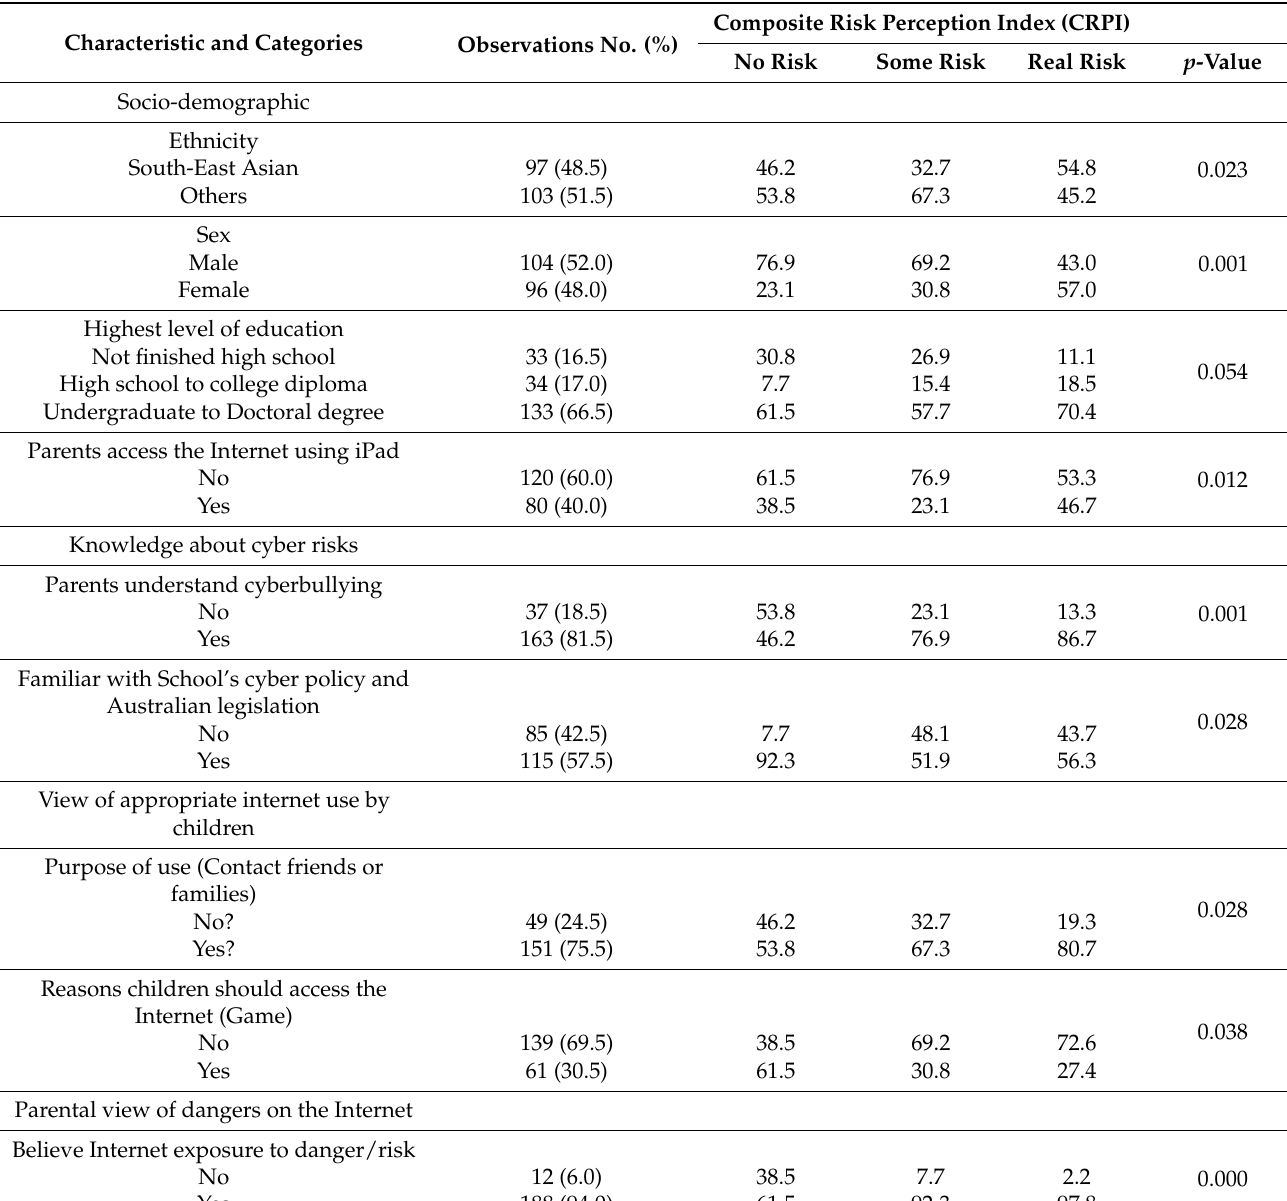
Table 2. Background characteristics of the participants and their percentage distribution by the Composite Risk Perception Index from selected ethnic/study groups/areas in Australia (n =